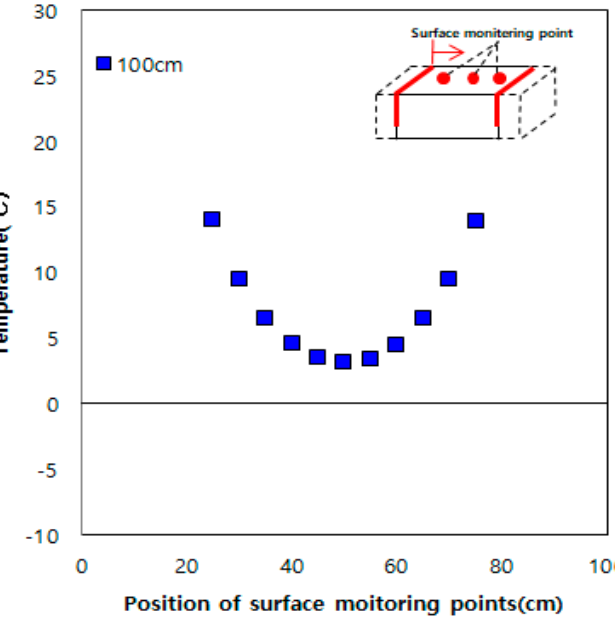
Figure 9. Results of numerical simulations for the field tests.